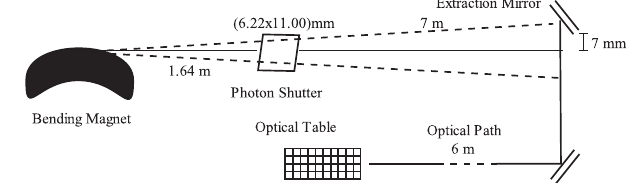
FIG. 2. Sketch ALBA diagnostic beamline, Xanadu. The synchrotron radiation beam is selected by a photon shutter located at 1.64 m from the source point. The in-vacuum extraction mirror is located 7 m downstream, 7 mm above the orbit plane. Seven other mirrors (already out of vacuum) bring the light from the tunnel to the Xanadu optical